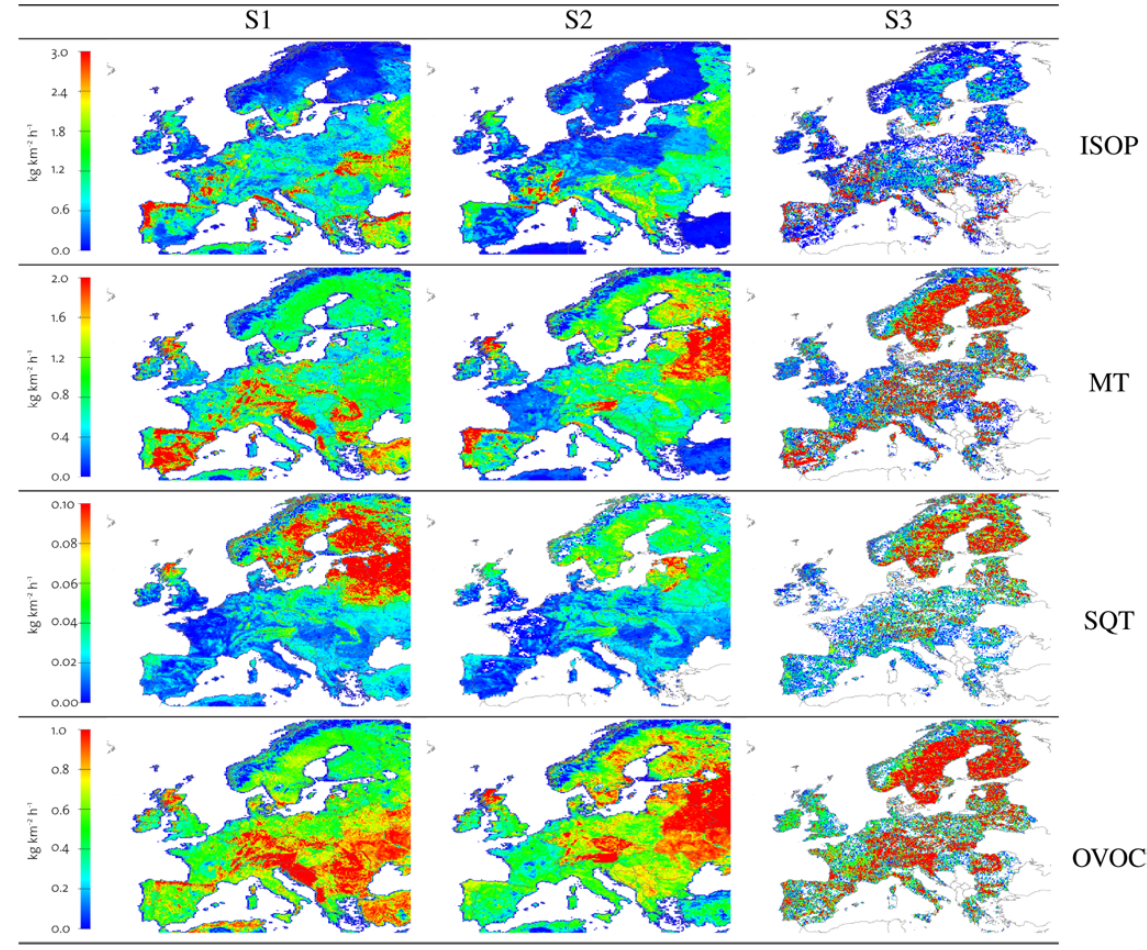
Fig. 5. Standard emission potentials SEP at T = 30 ◦ and PAR = 1000µmolm − 2 s − 1